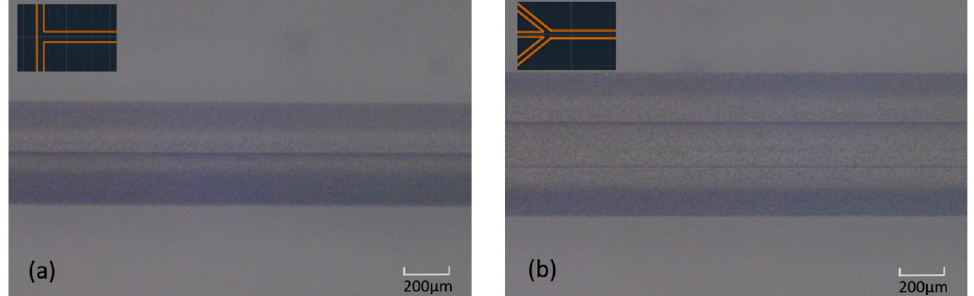
Figure 1. Laminar flow in a microfluidic channel: ( a ) two liquid phases flowing next to each other and forming two layers and one interface; ( b ) two liquid phases flowing next to each other and forming three layers and two interfaces. The microfluidic device architectures used to achieve these flow patterns are shown as inserts.